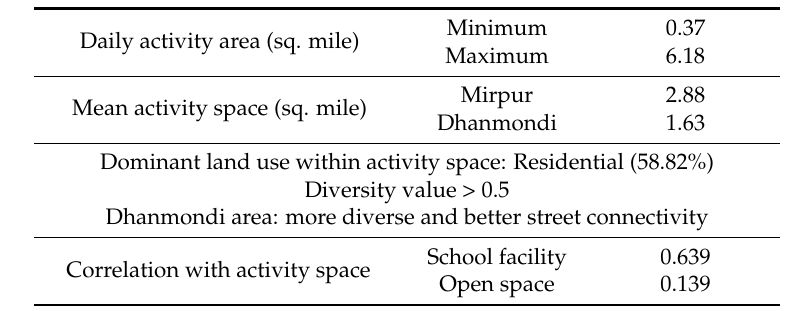
Table 7. Summary of pilot